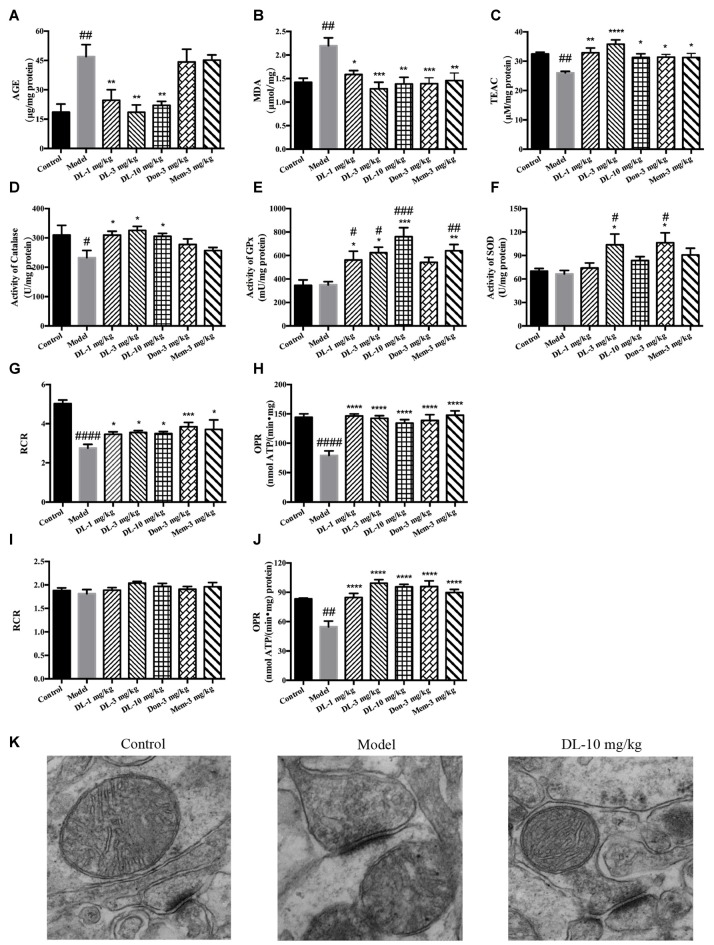
Effect of DL0410 on the oxidative stress, activity of anti-oxidative enzymes and mitochondrial respiration in the hippocampus and cortex. Data are the mean ± SEM (n = 5–6). (A) DL0410 could reduce advanced glycation end products (AGEs) levels in the hippocampus and cortex (F(6,29) = 7.307, p < 0.0001). (B) DL0410 decreased the production of malondialdehyde (MDA) in the hippocampus and cortex (F(6,29) = 5.353, p = 0.0008). (C) DL0410 could increase the total antioxidant capability of the hippocampus and cortex (F(6,29) = 4.900, p = 0.0014). (D) DL0410 could increase the activity of catalase in the hippocampus and cortex (F(6,27) = 2.973, p = 0.0232). (E) DL0410 could increase the activity of Glutathione peroxidase (GPx) in the hippocampus and cortex (F(6,21) = 7.373, p = 0.0002). (F) DL0410 could increase the activity of superoxide dismutase (SOD) in the hippocampus and cortex (F(6,28) = 3.642, p = 0.0085). The effect of DL0410 on mitochondrial respiration in the hippocampus and cortex using L-glutamate and L-malate (G,H) or succinate (I,J) as substrates. Data are the mean ± SEM (n = 6–8) (G,I) DL0410 could increase the RCR in the hippocampus and cortex (NADH chain F(6,46) = 10.46, p < 0.0001; FADH2 chain F(6,43) = 1.397, p = 0.2349). (H,J) DL0410 could increase the OPR in the hippocampus and cortex (NADH chain F(6,40) = 13.21, p < 0.0001; FADH2 chain F(6,35) = 12.49, p < 0.0001). (K) The representative electron micrograph of mitochondrion in the hippocampus CA1 area (magnification: 150,000×). #p < 0.05, ##p < 0.01, ###p < 0.001, ####p < 0.0001 vs. control group, *p < 0.05, **p < 0.01, ***p < 0.001, ****p < 0.0001 vs. model group.